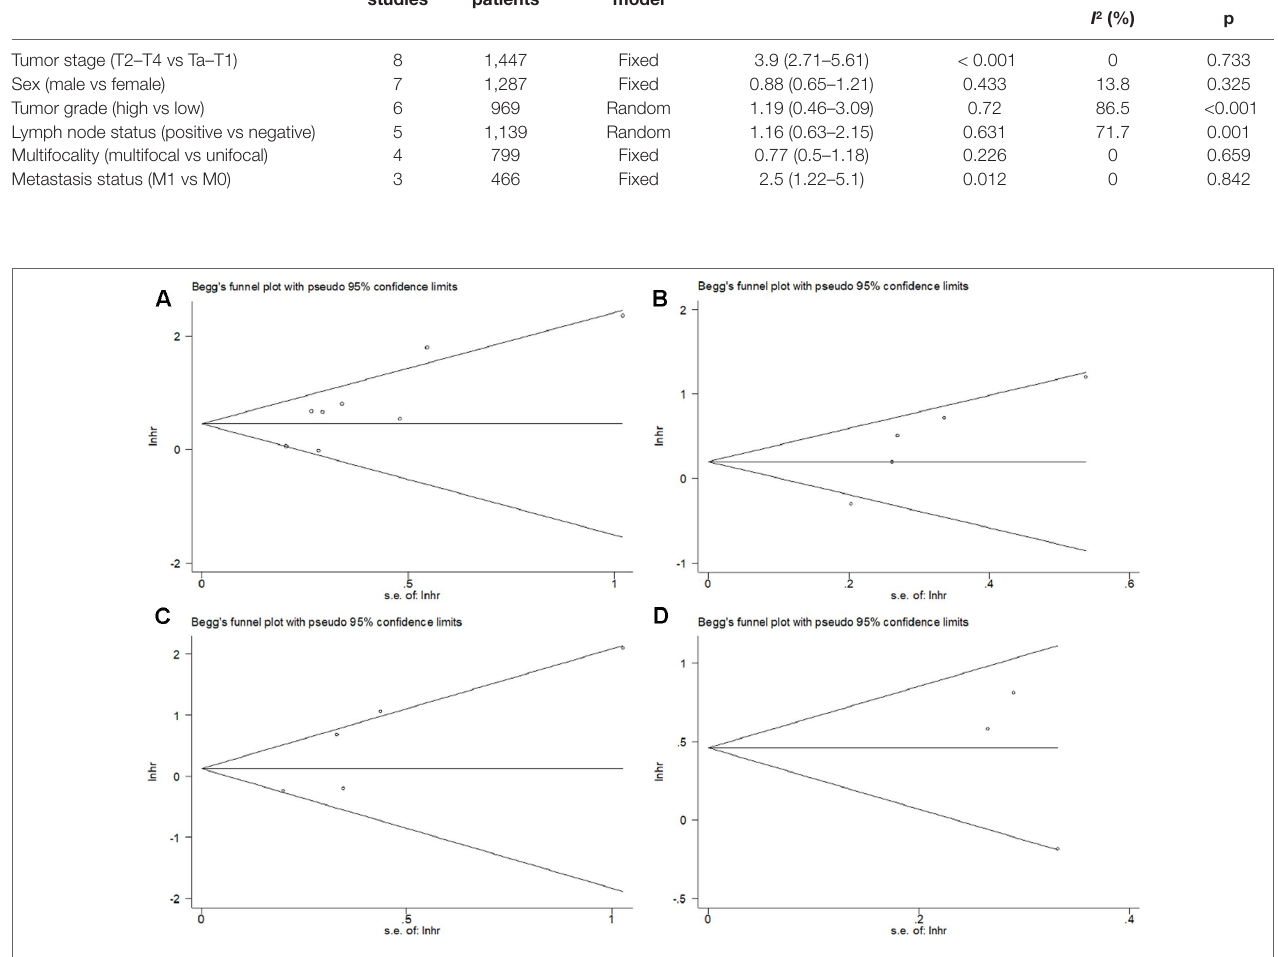
TABLE 3 | Association of PD-L1 and clinical factors in bladder cancer. Clinical factors